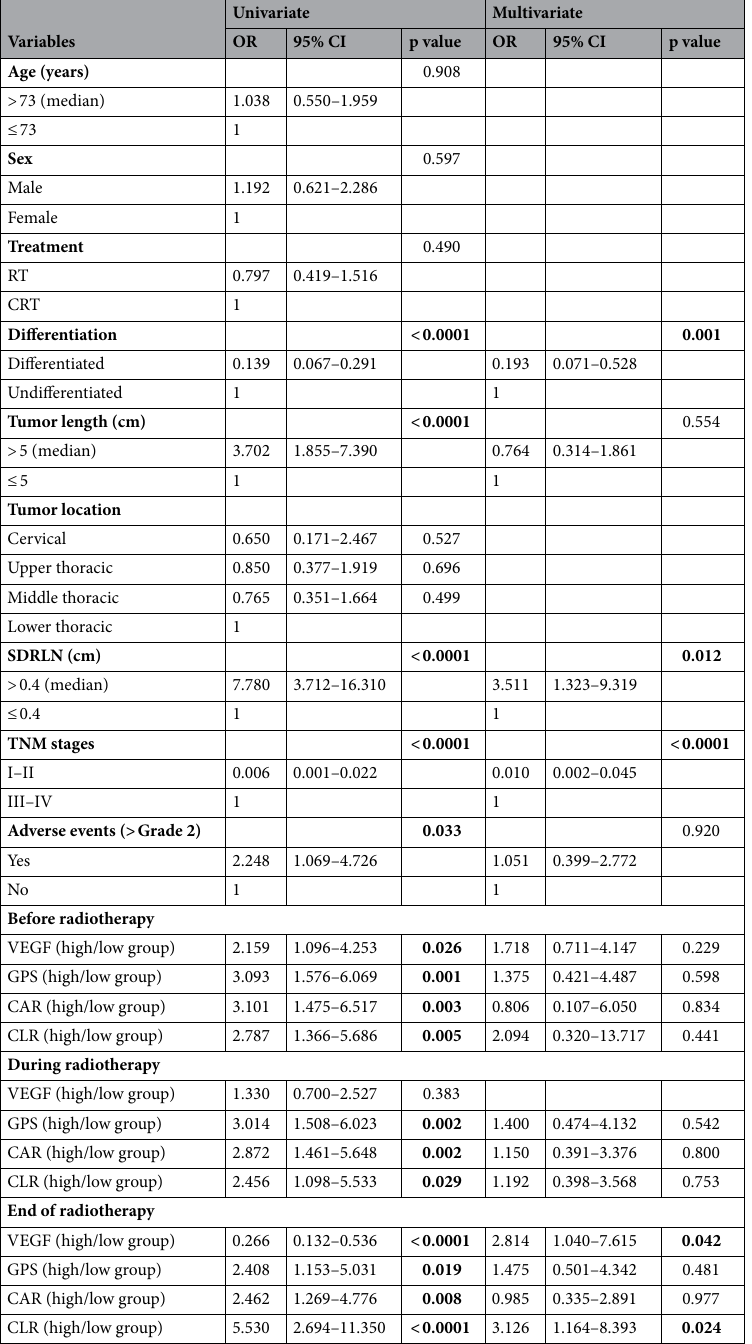
Table 2. Univariate and multivariate logistic regression analysis of clinical response. RT radiotherapy, CRT chemoradiotherapy, SDRLN short diameter of residual lymph node, VEGF vascular endothelial growth